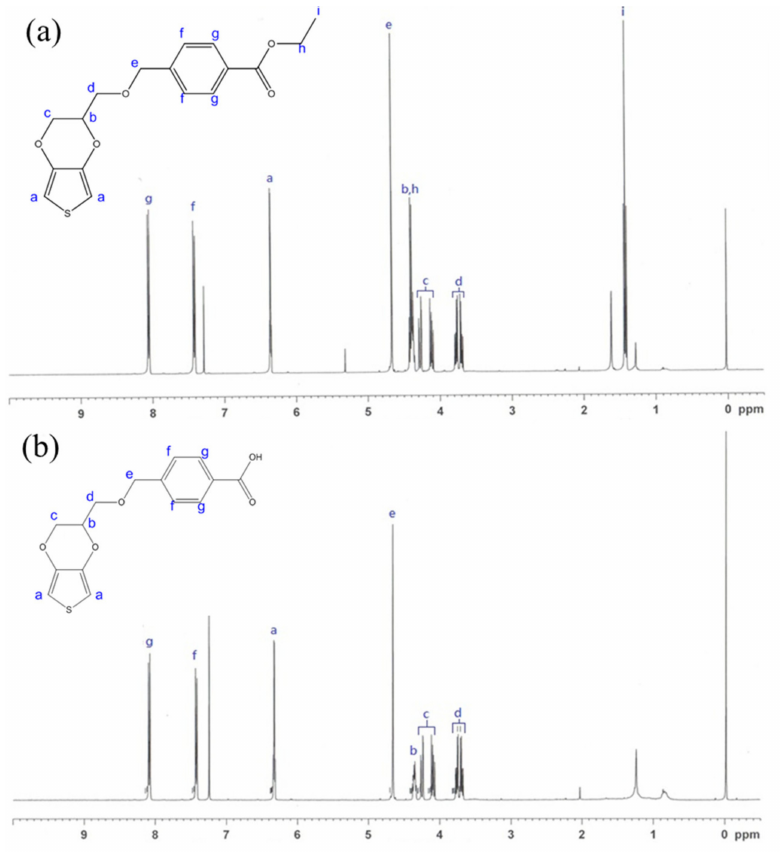
Figure 1. 1 H-NMR spectra of ( a ) EDOT-Ph-COOEt and ( b )